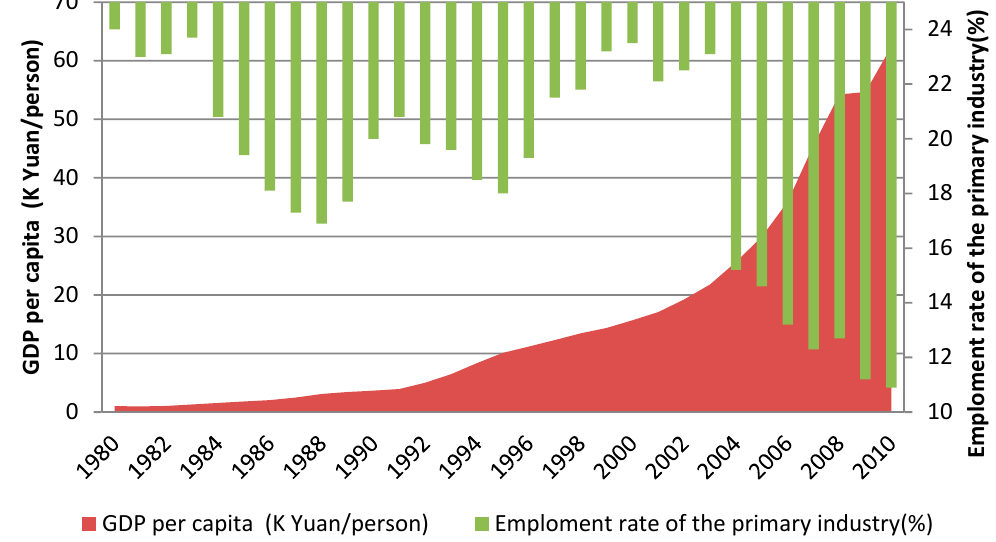
Figure 8. Trends of GDP per capita and primary industry employment ratio from 1980 to 2010.